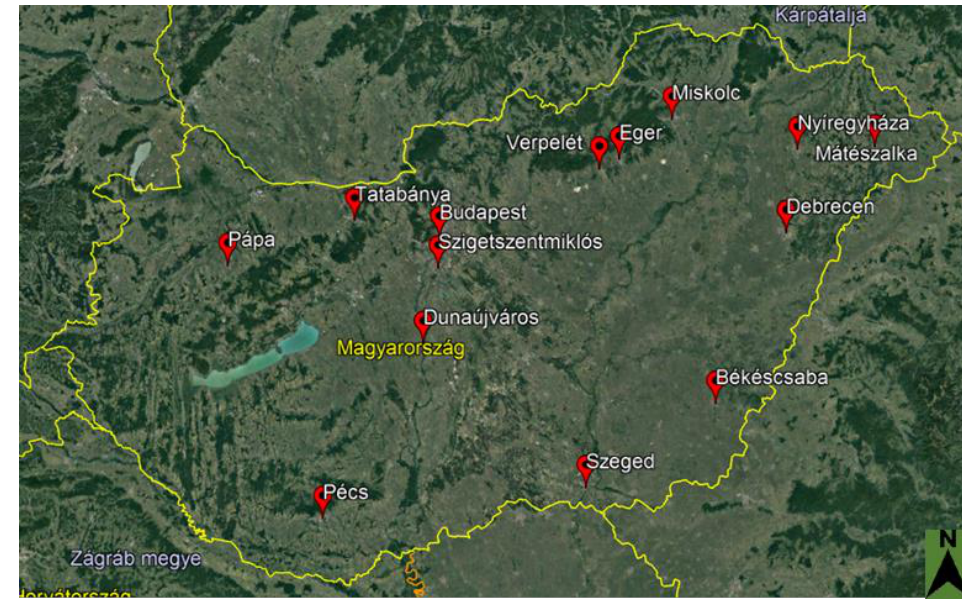
Figure 1. Locations of local community Facebook user groups in which the questionnaire was published. Source: Google Earth.